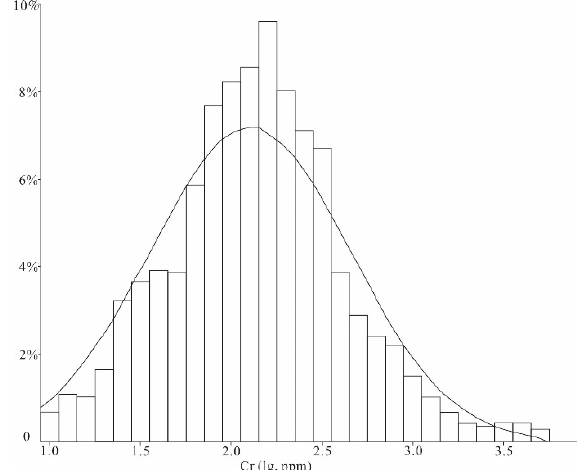
Figure 3. Histogram of chromium element.